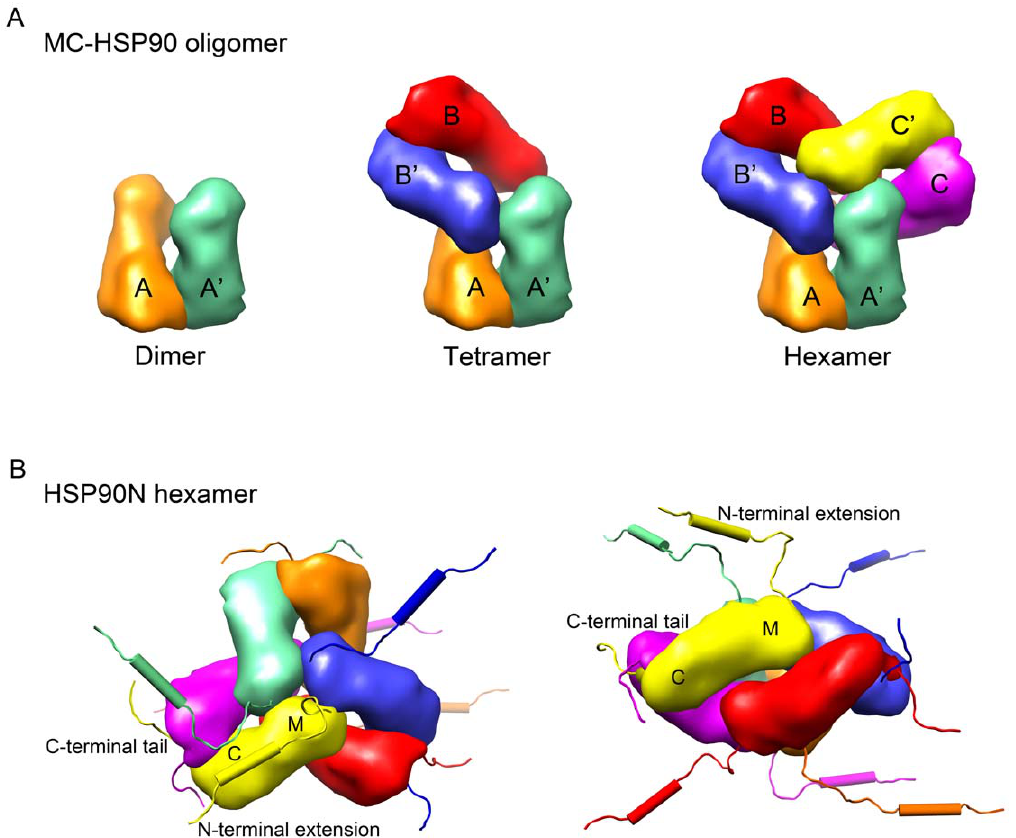
Figure 7. MC-HSP90 assembly and models of HSP90N hexamer. (A) Assembly of MC-HSP90 hexameric structure. The process begins with a monomer (orange) subunit associating with another monomer (green) to form a stable dimer as the building block. It continues with further association of dimers via the N-terminal interface of M domain to form a possible dimer of dimers (or tetramer) and a stable hexamer. The occurrence of tetramer might represent an intermediate. In the models of MC-HSP90 dimer, tetramer and hexamer shown here, the building blocks are paired and indicated by the labels AA 9 , BB 9 and CC 9 . (B) Top view and side view of HSP90N hexamer with 12 flexible polypeptide segments hanging around the core structure. The protomers of hexameric HSP90N are represented by different colors, green, orange, blue, yellow, red, and megenta. The N- terminal hydrophilic extension and C-terminal tail of the yellow protomer are labeled.